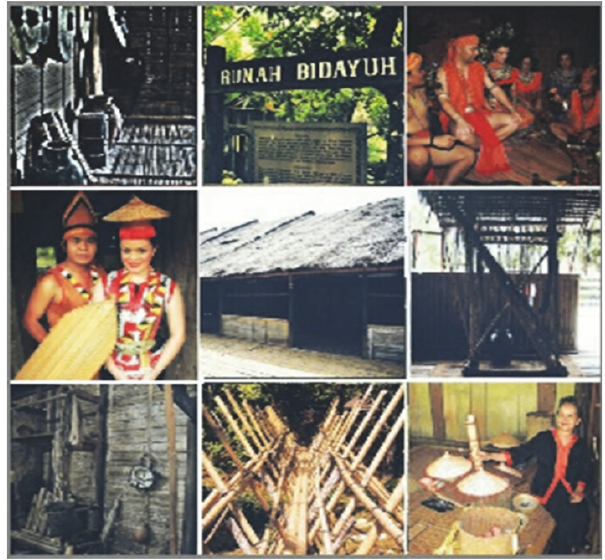
Figure 2: Various artefacts and activities at one of the ethnic house.